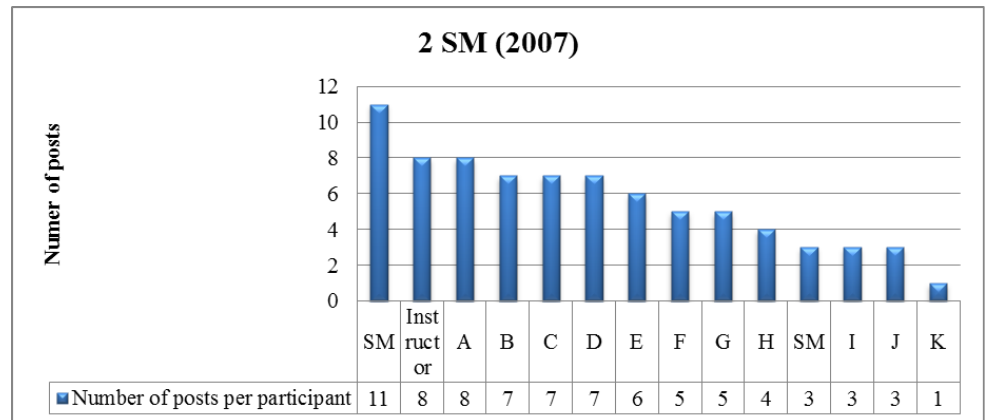
Figure 2. Number of posts per participant of 2 SM forum.